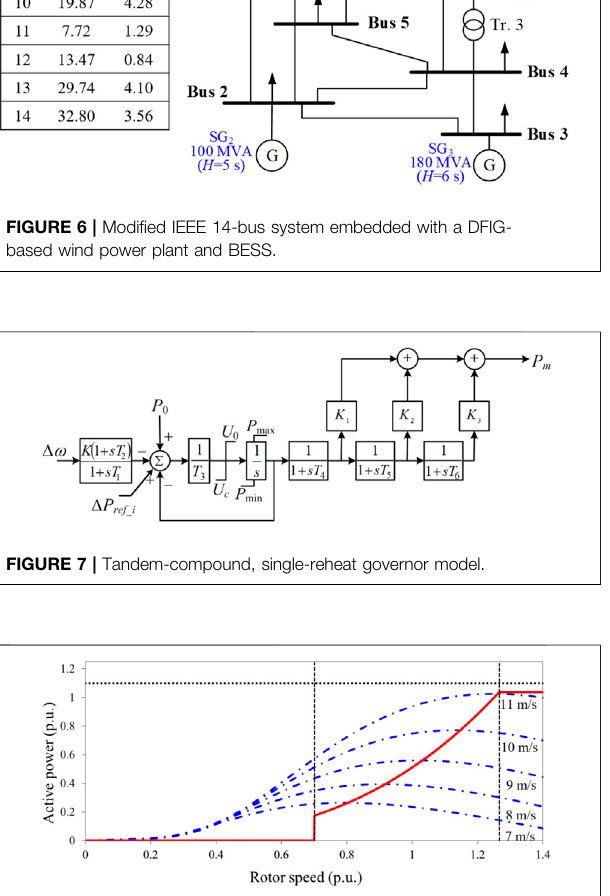
FIGURE 8 | Operating characteristics of the